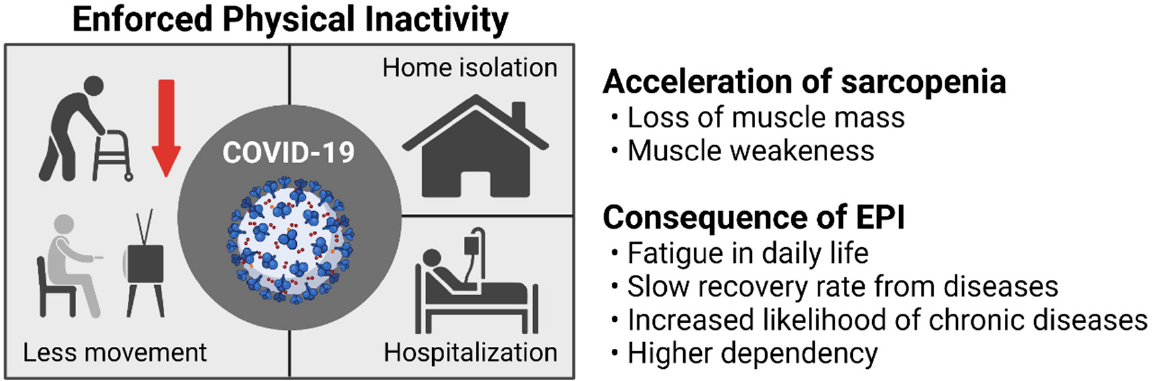
Figure 1. The COVID-19 pandemic spread around the world, forcing people, particularly older adults, to physically restricted conditions, including home isolation and hospitalization. These conditions resulted in further reductions in daily physical activity, leading to deterioration of muscle health (loss of muscle mass and function) in older adults, which is closely associated with worse consequences, including fatigue in daily life, slow recovery rate from diseases, increased likelihood of chronic disease, and thus inability of their independent life. The figure was created by BioRender.